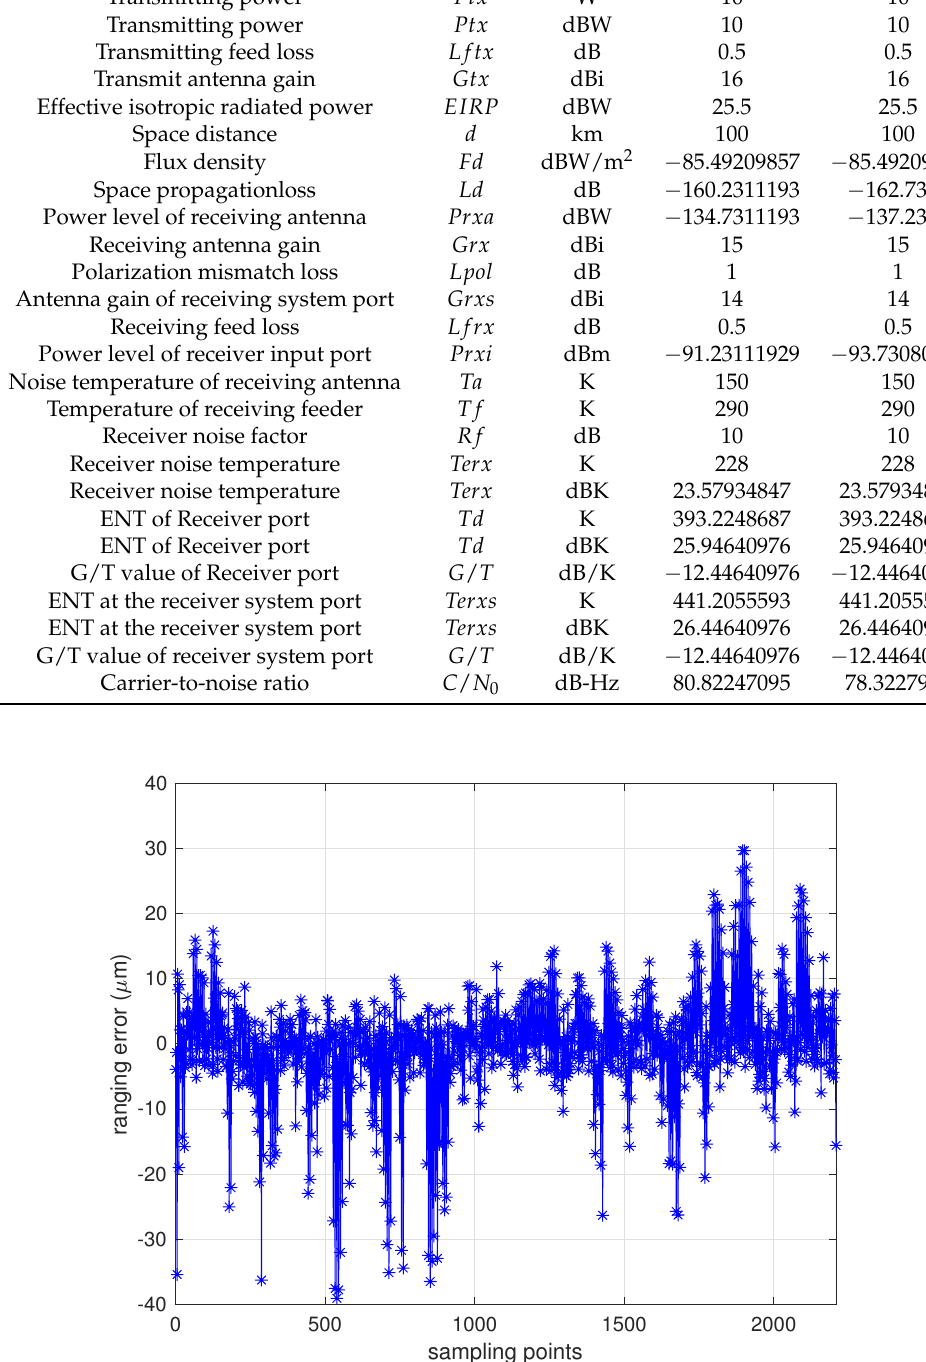
Figure 8. MWR ranging errors of 2400 samples, with data collected from a 6-DOF moving platform under a relative longitudinal velocity of 5 µ m/s. The ranging errors were less than 40 µ m during the